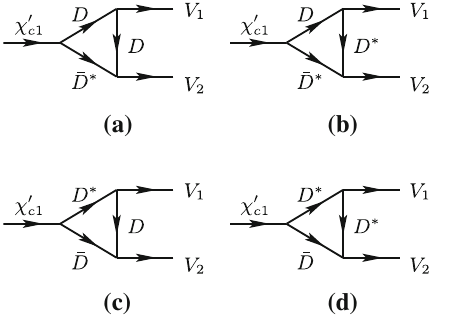
Fig. 2 The hadron-level diagrams for charmless decay modes χ (cid:2) V P via intermediate charmed meson